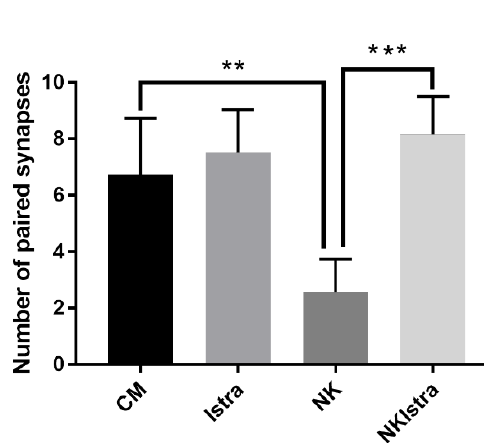
Figure5. Ribbonsynapsesinthemid-cochlearregionofP6Wistarrats. Cochleartissuesimmunolabelled with PSD95 (postsynaptic density protein, green), CtBP2 (synaptic ribbons, red) and myosin VIIa (inner hair cells, grey) antibodies in ( A ) normal culture medium (CM); ( B ) with addition of istradefylline (Istra); ( C ) with NMDA / kainic acid (NK); ( D ) a combined NKIstra treatment. Scale bars, 20 µ m. Figure 5. Ribbon synapses in the mid-cochlear region of P6 Wistar rats. Cochlear tissues ( E ) Number of paired synapses per inner hair cell in di ff erent treatment groups. Data presented as mean ± SEM. CM, n = 5; Istra, n = 5; NK, n = 4, NKIstra, n = 6. ** p < 0.01; *** p < 0.001, one-way ANOVA followed by a post-hoc Sidak’s multiple comparisons test. Images A–D are representative of the number of experiments shown for each group.